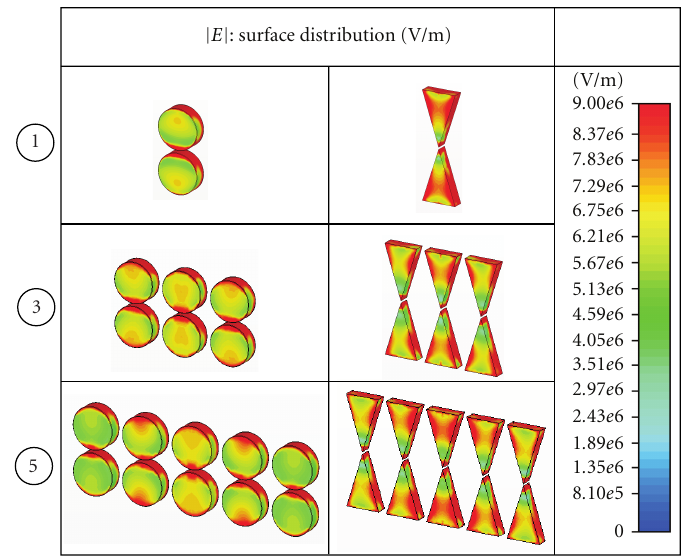
Figure 6: Absolute value of the field distribution for 1-, 3-, and 5-element arrays, for both the disc dimer and bowtie ( r = 40nm, gap = 5nm). The field is generated by a dipole with length 5nm and current 1A.